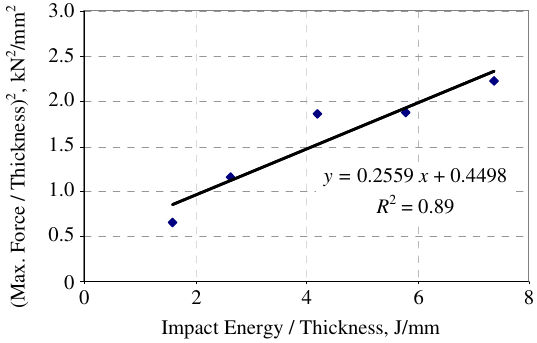
Fig 6. Maximum force normalized with thickness to the impact kinetic energy For composite materials, especially for glass/epoxy laminates, the case of delamination is important because of low interlaminar shear strength. Making